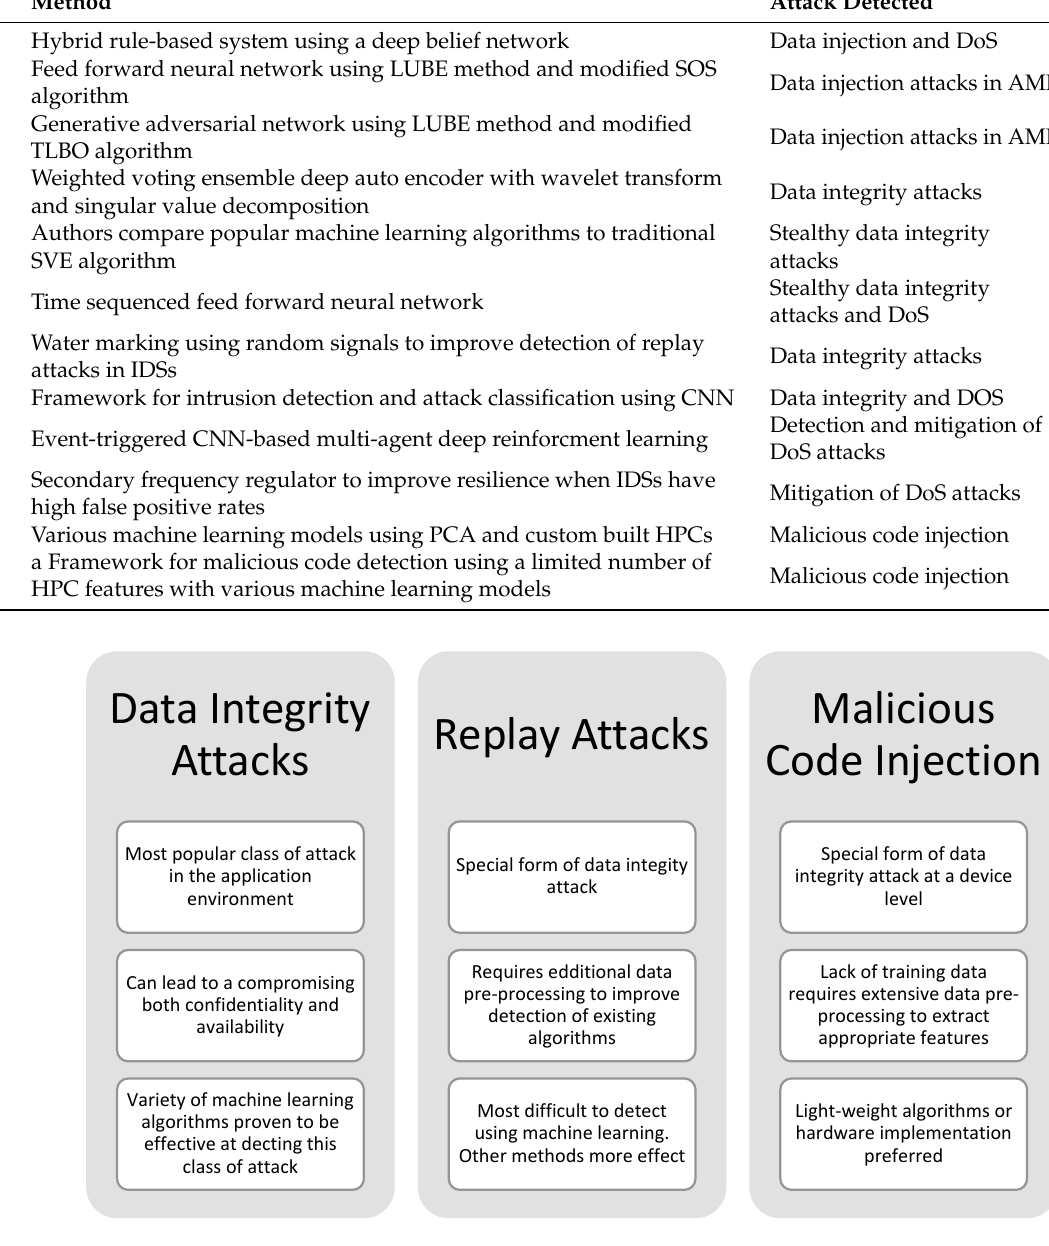
Figure 5. Summary of Microgrid